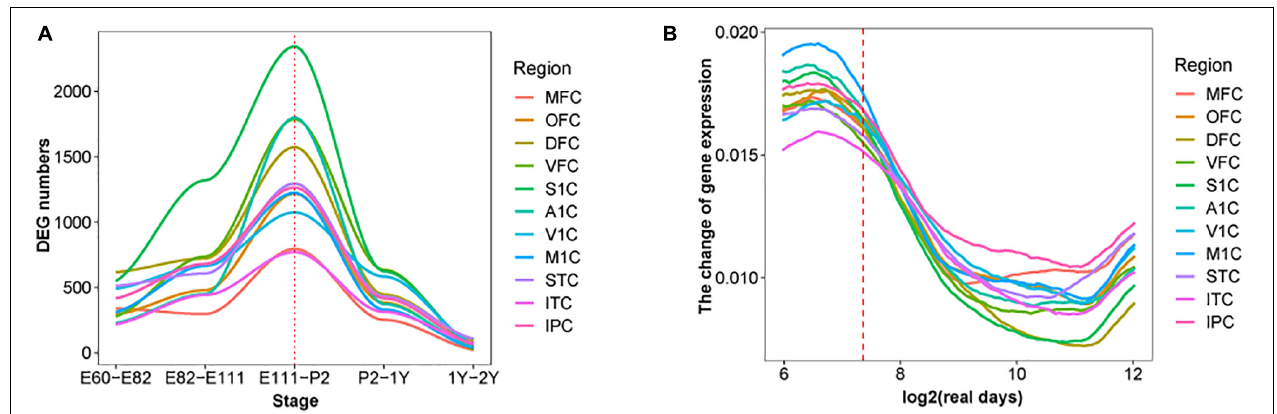
FIGURE 2 | DEGs in each brain region over time in macaque brain. (A) The distribution of DEGs in 11 brain regions in rhesus macaques, the x -axis represents developmental period, the y -axis is the number of DEGs, colors represent distinct brain regions and the red dotted line indicates birth time. (B) Changes in fitting curves of different brain regions in rhesus macaques, the expression value of each gene was fitted over time, 100 time points were selected and then the top 20% of the greatest difference was